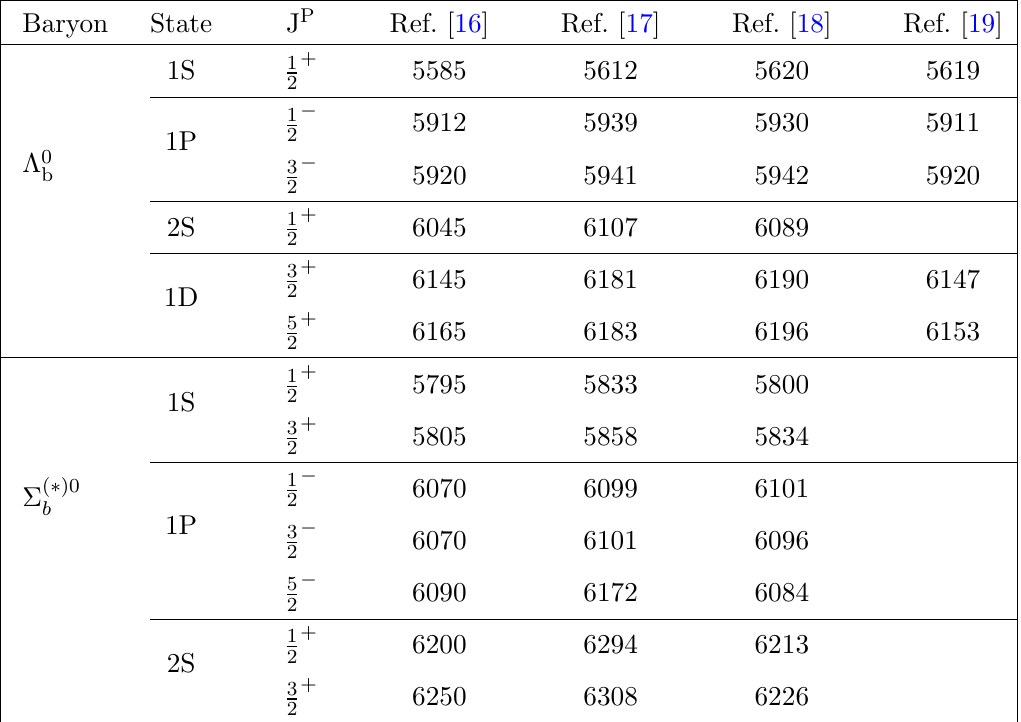
( ) states (in MeV). (cid:3) b and (cid:6) b